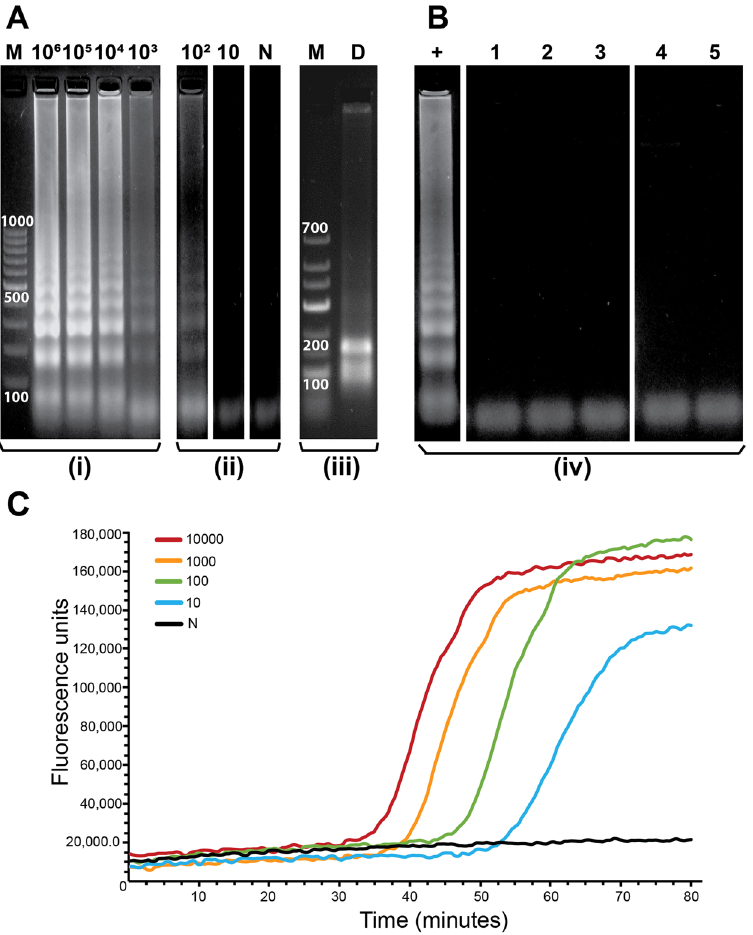
Figure 3. LAMP in tube. ( A ) Gel electrophoresis analysis of products of LAMP reactions conducted in tube with varying starting copy numbers of Mtb gDNA (10 6 copies up to 10 copies). The numbers on top of the lanes indicate the starting copy number of the template. N- No template control, M- DNA marker and D- digested LAMP amplicons. Reaction time was 40 minutes. ( B ) Specificity of the LAMP assay tested against non- Mtb targets. + : Positive control ( Mtb gDNA), 1: Human gDNA, 2: E. coli gDNA, 3: Mycobacterium smegmatis gDNA, 4: plasmid with hepatitis C insert, 5: plasmid with dengue insert. ( C ) Real-time amplification curves for LAMP in tube. Reaction time was 80 minutes. (i–iv) denote lanes from different gels. Full-length gels are presented in Supplementary Fig. S9 (i), (ii), (iii) and